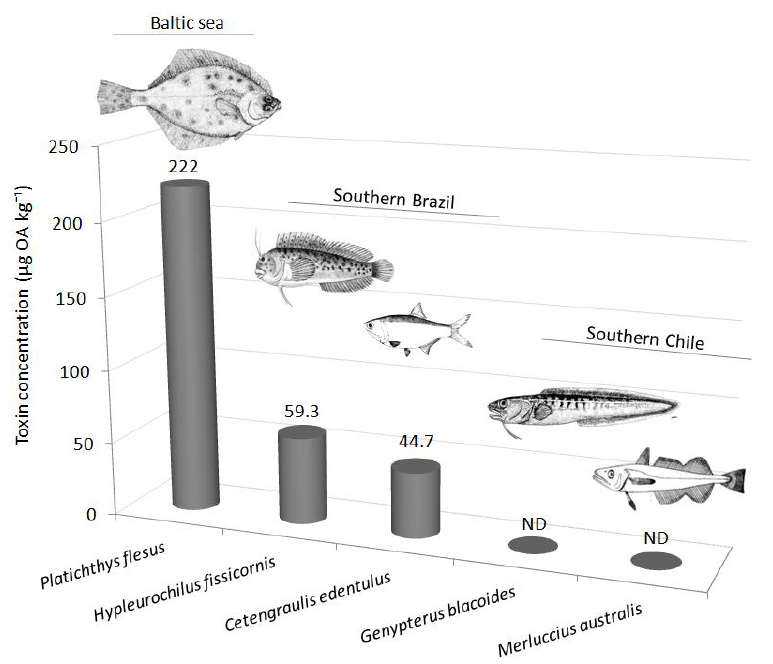
Figure 2. Documented levels of okadaic acid ( µ g kg − 1 ) determined in fish worldwide [2,30–32]. ND: not detected.